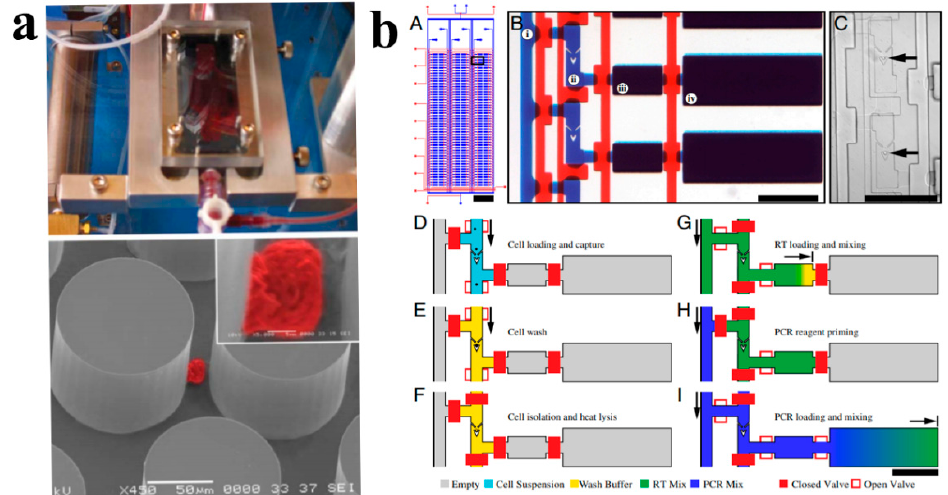
Figure 5. ( a ) Specially designed microfluidic device can capture cancer cell (pseudo colored red) from whole blood in single step [114]. Reproduced with permission from Sunitha Nagrath; et al. Nature; published by Springer Nature, 2007. ( b ) Design and operation of the microfluidic system for single-cell high-precision RT-qPCR gene expression analysis [115].